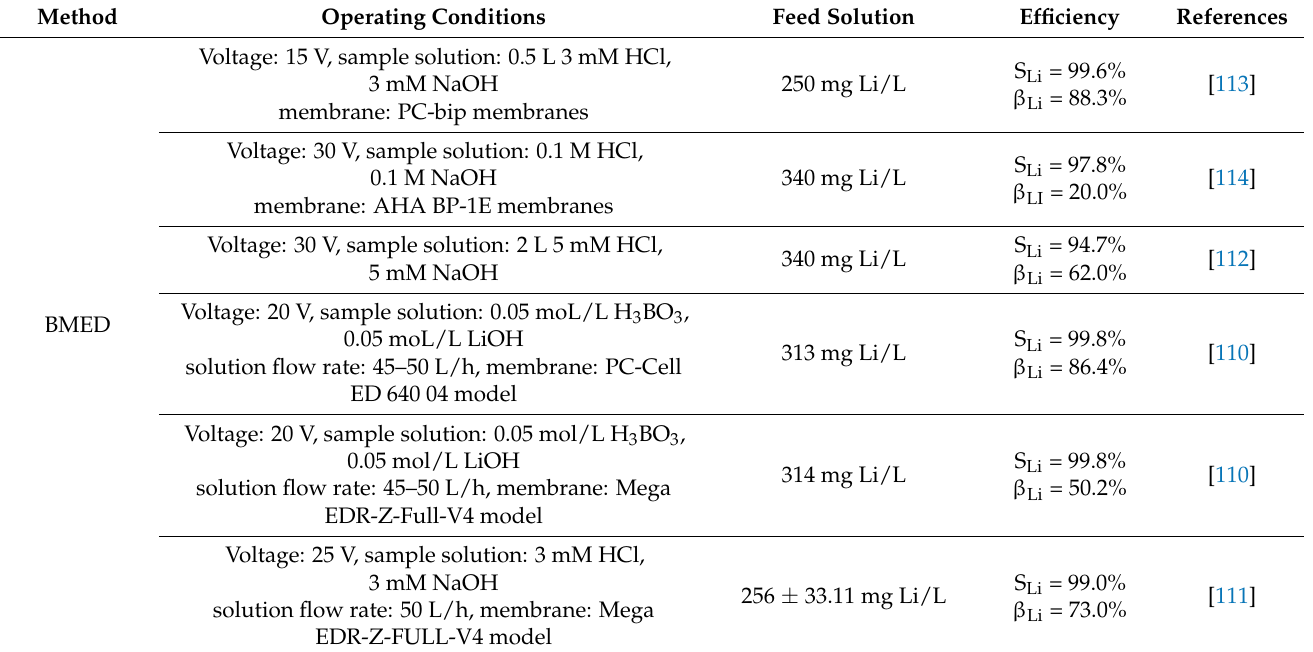
Table 3. Separation and recovery of lithium from aqueous solutions using